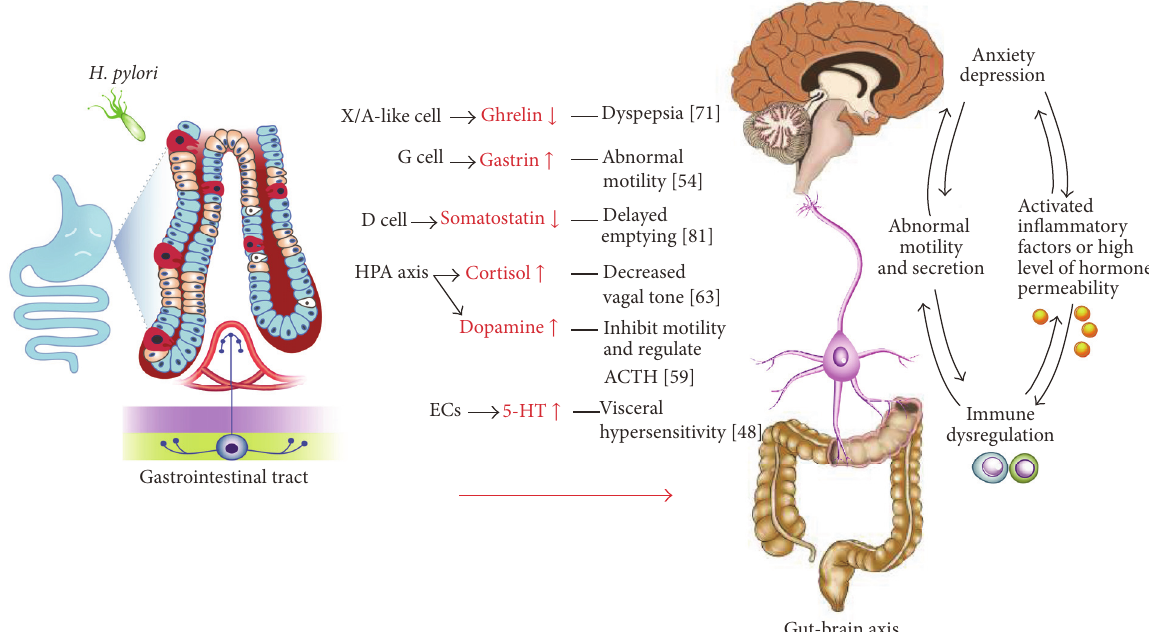
Figure 2: Effects of gastrointestinal hormones level to mental disorders after H. pylori colonization. CagA-positive H. pylori strains could induce fluctuations in the levels of serotonin (5-HT), ghrelin, dopamine, and cortisol, and might be the cause of some dyspepsia symptoms and mental disorders through blood circulation and brain-gut